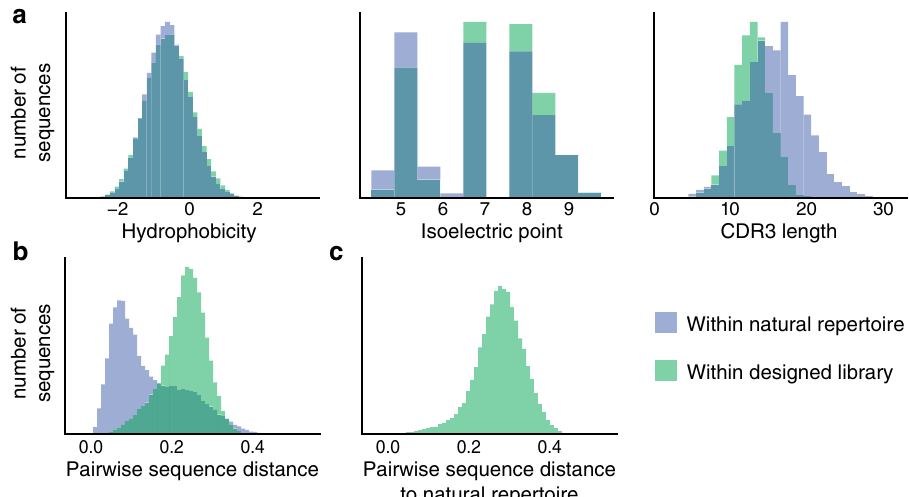
Fig. 3 The designed library has comparable biochemical property distributions and improved diversity to the natural llama repertoire. a Conditioned on the framework-CDR1-CDR2 sequence, a diverse set of CDR3 sequences are generated and selected. These designed CDR3 sequences (green) are similar to the natural repertoire (blue) in their distributions of hydrophobicity 105 and isoelectric point 106, 107 , while having shorter length distributions due to selection strategies in the fi nal library construction. b The designed library contains more diversity in sequences than the natural repertoire as evidenced by the larger cosine distance to its nearest neighbor. c Each sequence in the designed library is diverse from any sequence seen in the natural repertoire, indicating that we have learned fi t sequence constraints but are traversing previously unexplored regions of sequence